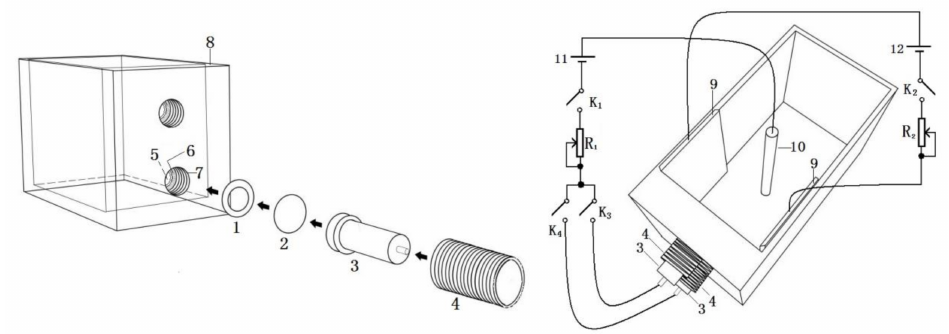
Figure 1. Schematic diagram of double working electrodes